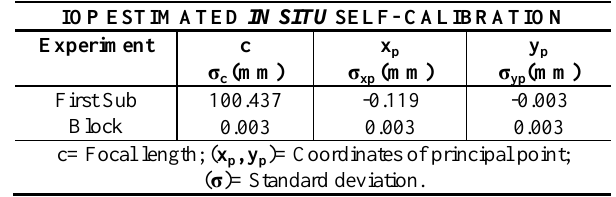
Table 1. The interior orientation parameters (IOP) and its precisions estimated in